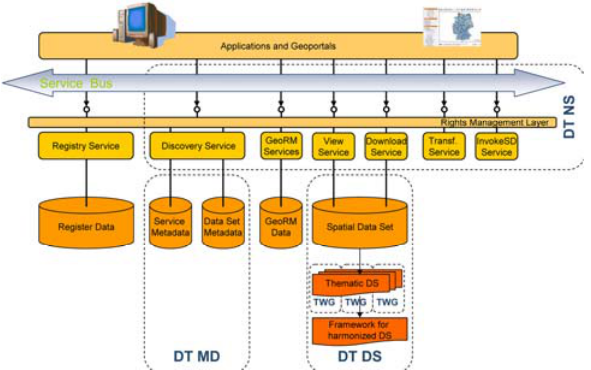
Figure 1. INSPIRE Architecture overview (European Com- mission Joint Research Centre,